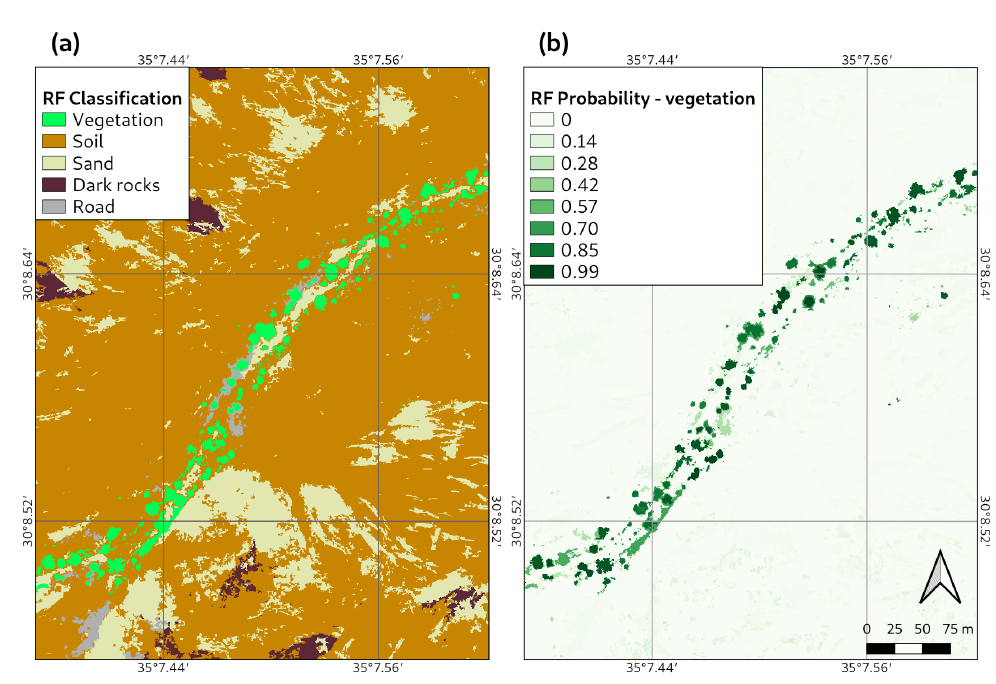
Figure 4. Random Forest (RF) classification result ( a ) and RF probability raster ( b ) in a section of the Shitta study